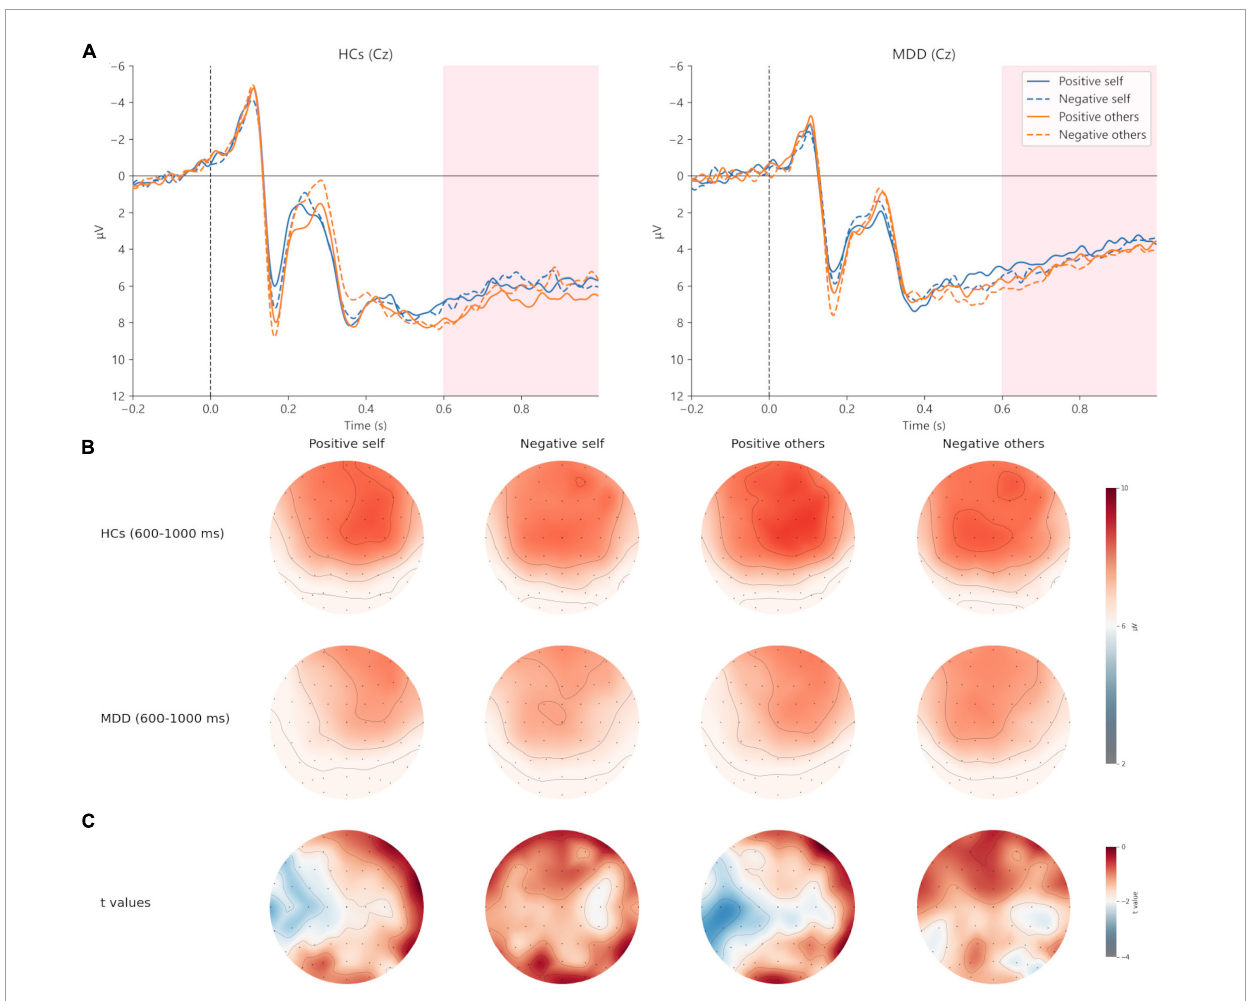
FIGURE7 Grand averages (A) of LPP (600–1,000 ms) at Cz electrodes under positive self (blue solid lines), negative self (blue dashed lines), positive others (orange solid lines), and negative others (orange dashed lines) condition. Topographic distribution (B) of grand averaged LPP within a time window of 600–1,000 ms under four conditions. Topographic distribution of t values for LPP between MDD and HCs (C) under four conditions. MDD, major depressive disorder; HCs, healthy